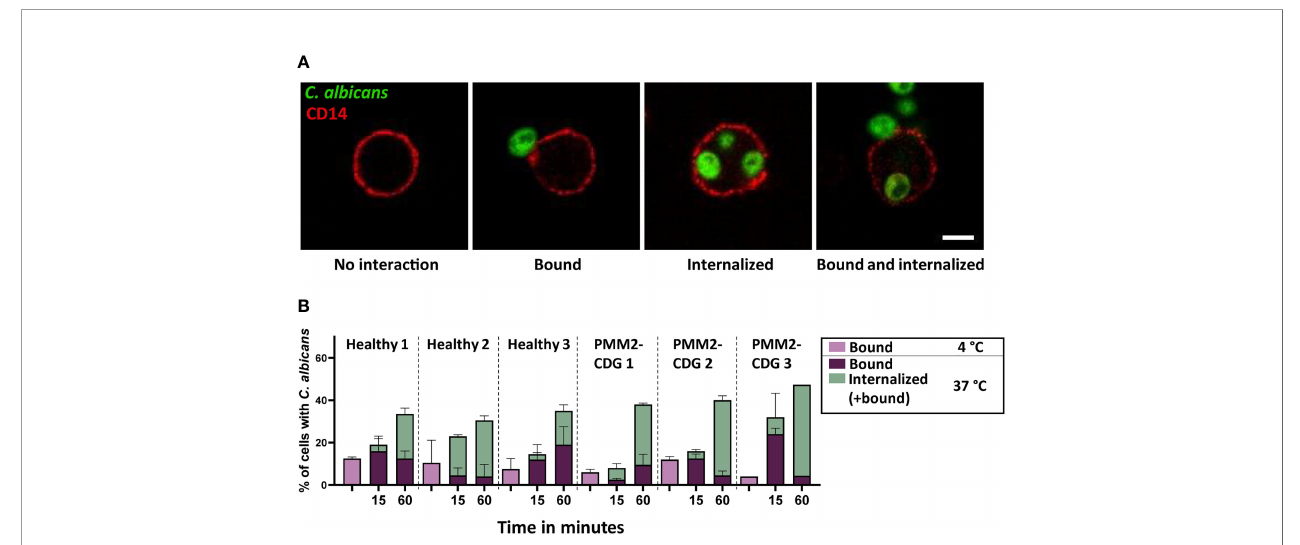
FIGURE 2 | Binding and phagocytosis by PBMCs of healthy donors and PMM2-CDG patients. (A) Confocal microscopy images of monocyte interactions with C. albicans . The cell membrane is labelled by CD14 staining. Scale bar = 5 µm (B) Binding and uptake of C. albicans by healthy and PMM2-CDG patient monocytes after 15 or 60 m coincubation at 37°C. Samples incubated for 60 m at 4°C were included as a negative control. The experiment was performed in duplicate, except for the PMM2-CDG 3, 60 m at 37°C condition which includes one measurement. Mean ±